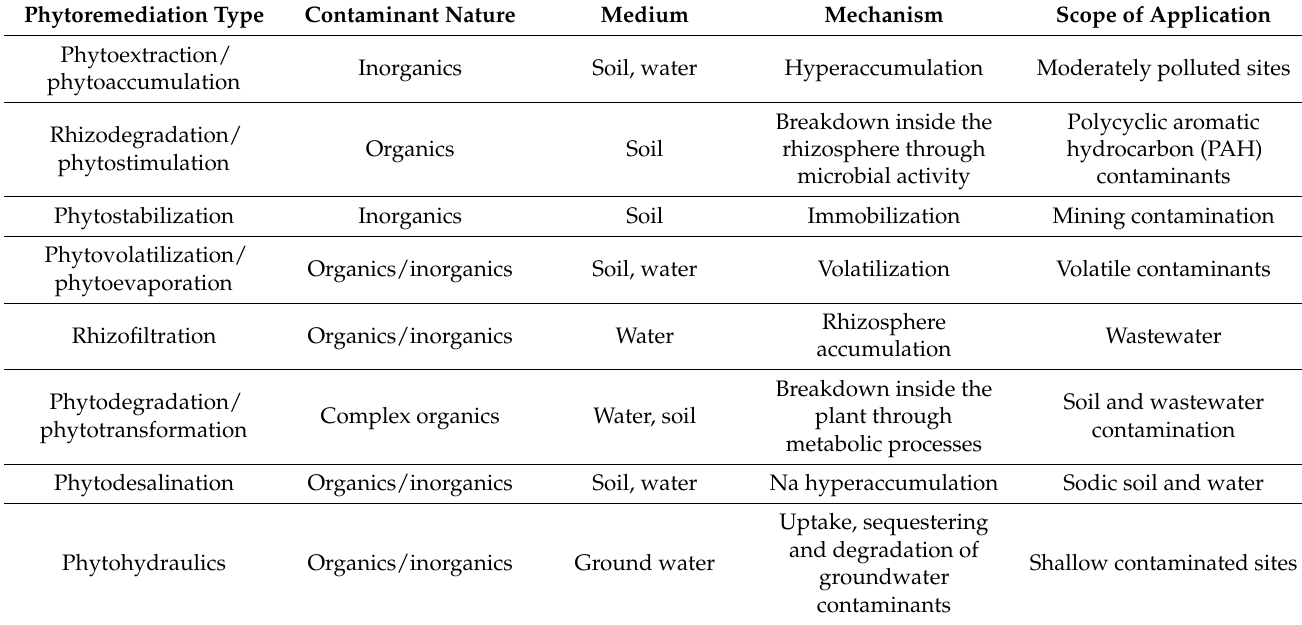
Table 1. Various types of phytoremediation methods [28].